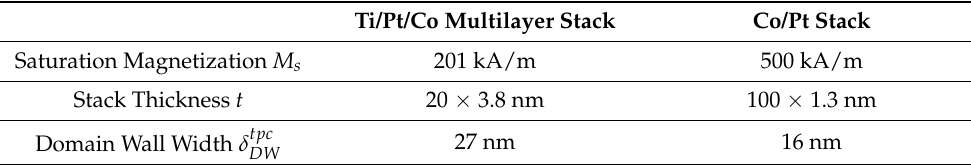
Table 1. Sample parameters required for the calculation of the effective magnetic charge density of the Ti/Pt/Co sample and the Co/Pt reference